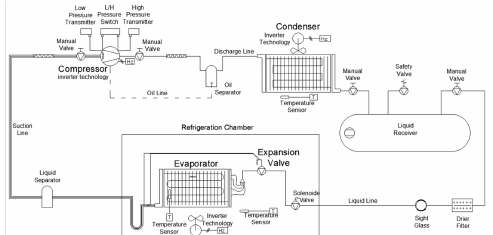
Figure 3. Diagram of the refrigeration system.